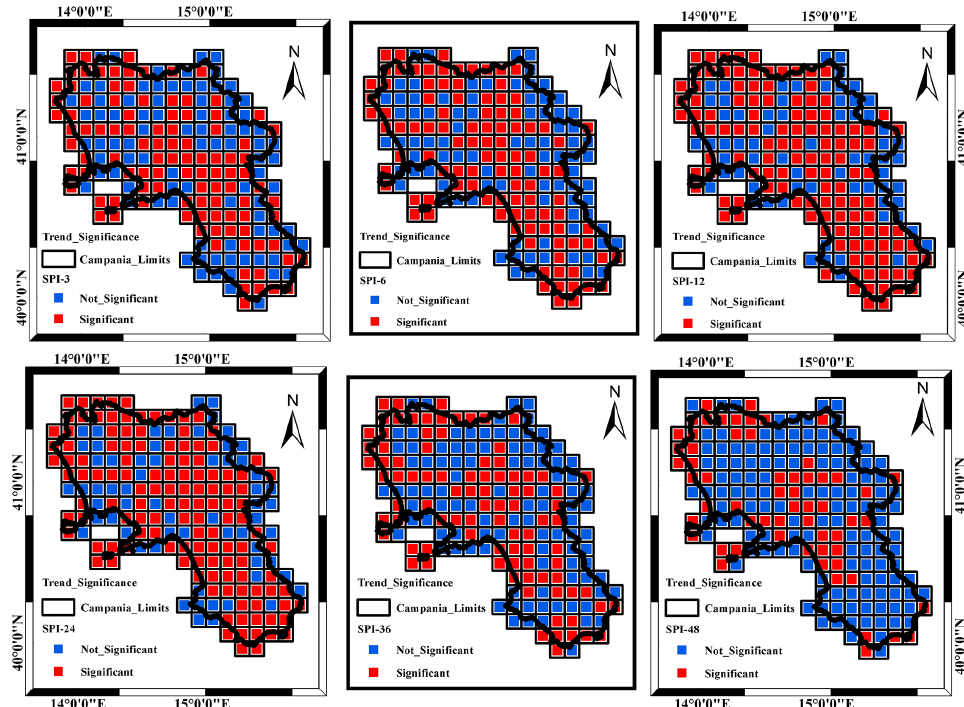
Figure 5. SPI MMK test significance ( α = 5%) for the different accumulation scales.